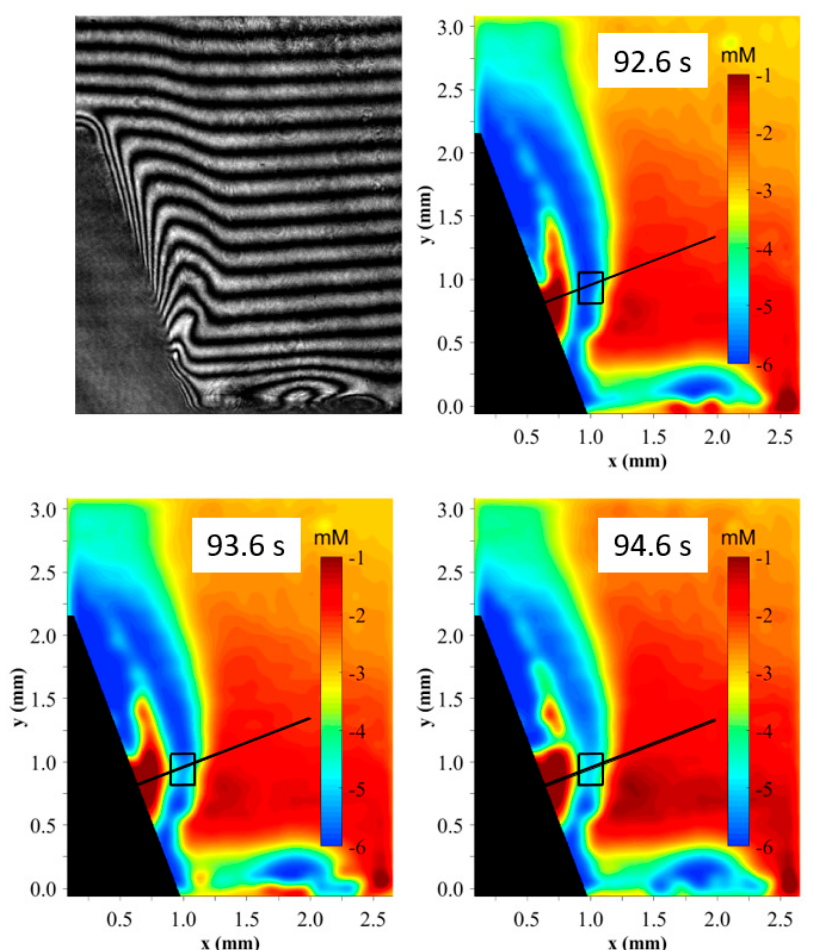
Figure 4. ( a ) Oscillations of the concentration in electroless deposition (J = 0 mA/cm 2 ) averaged in the region of interest (ROI) marked in Figure 5 (rectangle). The inset shows an expanded view of the oscillations. ( b ). Concentration variation profile along the black line marked in Figure 5.